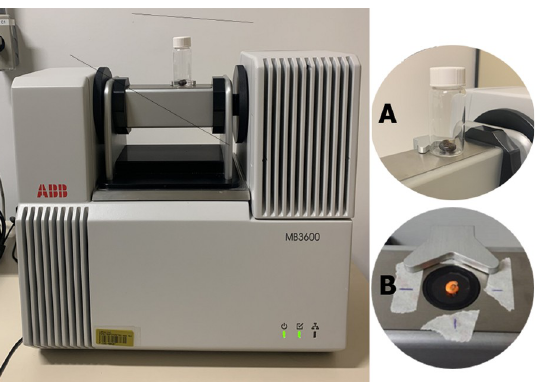
Fig 3. Near Infrared Spectrophotometer equipment. (A) Glass vial containing a live specimen of Biomphalaria glabrata ready to be measured by the FT-NIR through the window of the apparatus. (B) Dry shell of Biomphalaria glabrata placed directly into the FT-NIR